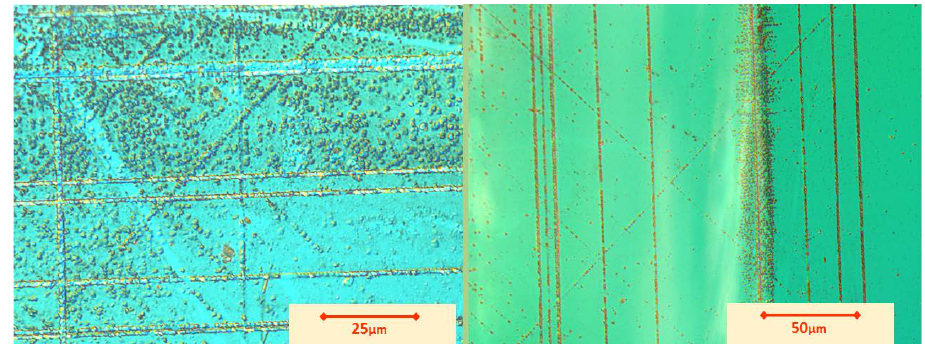
Figure 17. Thermal annealing of SrTiO 3 (100) crystals (oxidation at 1000 °C, 200 mbar O 2 , t = 45 h) ( left ); forced arrangement of dislocations along <100> and <110> directions ( right ).